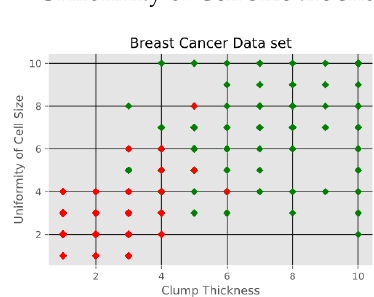
Figure 3. Illustration of the first two attributes of the Iris data set. 2. Breast Cancer Wisconsin (Original) data set consisting of 699 instances and containing 10 attributes. Instances are classified into one of two categories, benign or malignant. The attributes are as follows: clump thickness, uniformity of cell size, uniformity of cell shape, marginal adhesion, single epithelial cell size, bare nuclei, bland chromatin, normal nucleoli, and mitoses. The first two attributes i.e. Clump Thickness and Uniformity of Cell Size are shown in Figure 4.